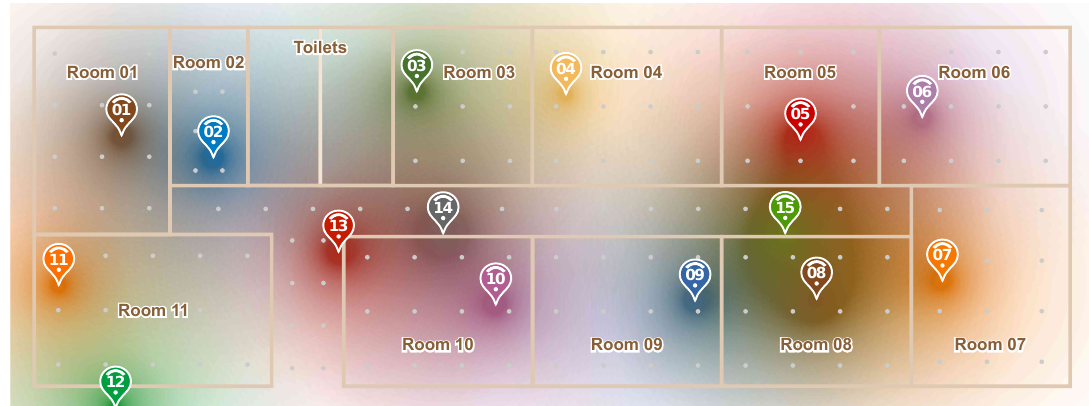
Figure 7. Signal characterization of the environment using the signal propagation model.